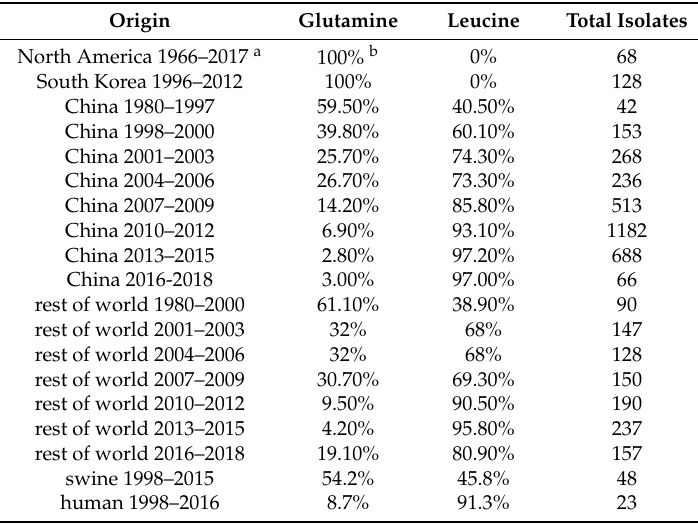
Table 1. Comparison of amino acid variation at position 226 (H3 numbering) of H9N2 isolates from different geographic